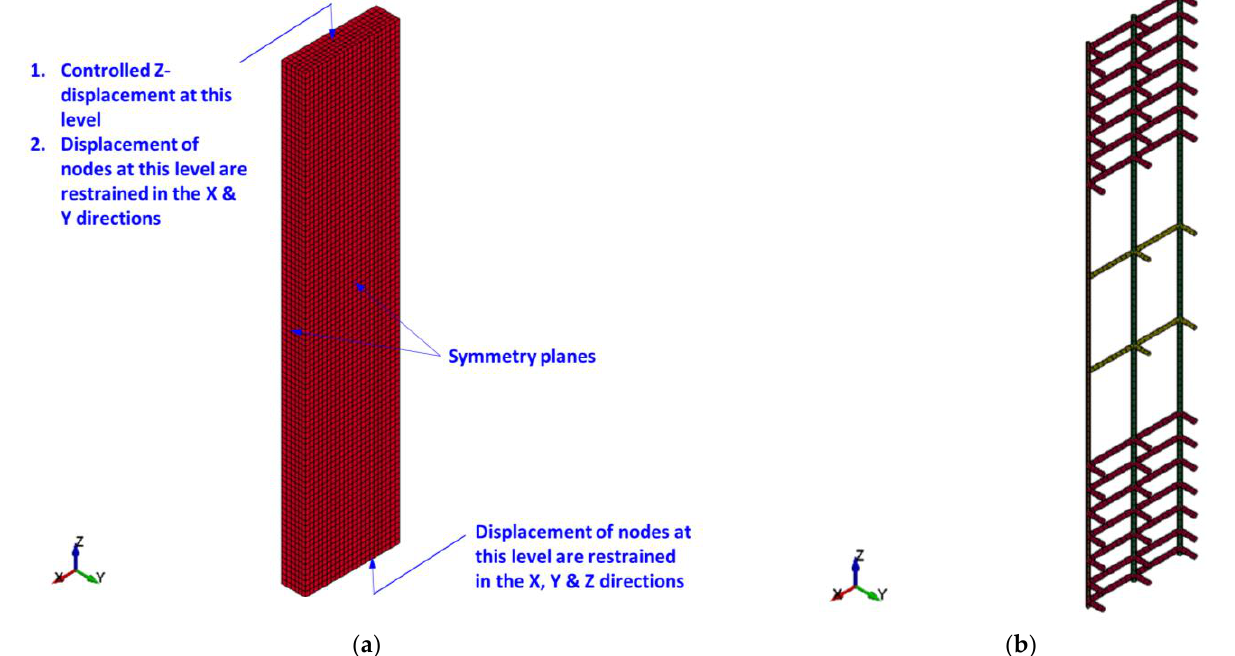
Figure 15. FE mesh for control specimen CW: ( a ) concrete volume; ( b ) reinforcement cage.